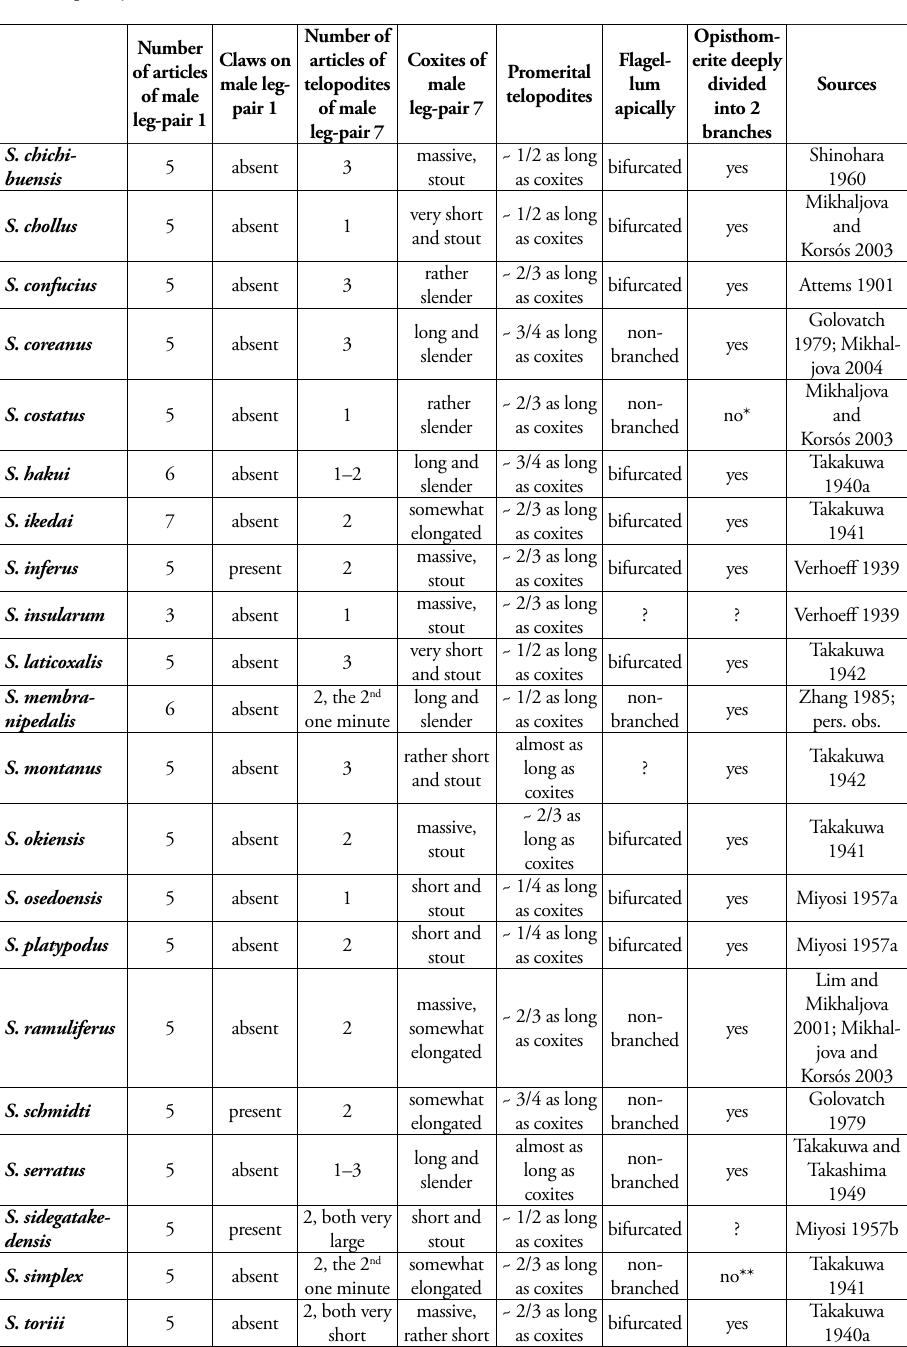
Table 1. Main diagnostic characters of species of Skleroprotopus . Symbols: * - divided apically; ** - completely